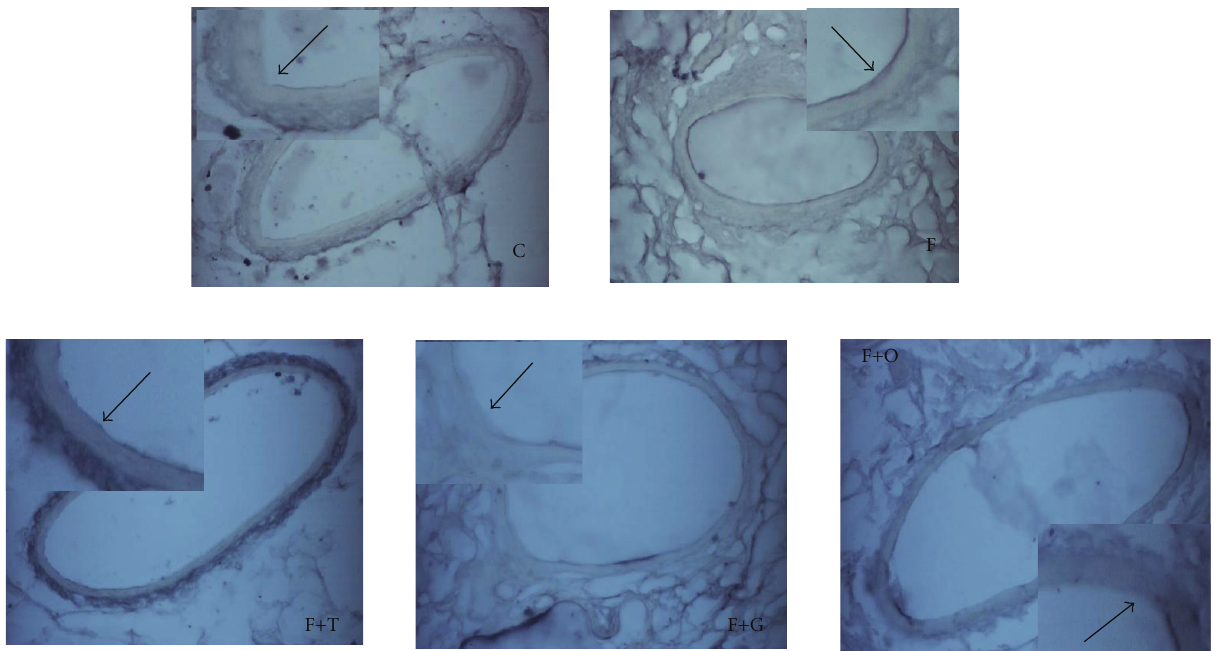
Figure 5: Immunohistochemistry analysis of VCAM-1 in endothelial cells of vascular mesenteric tissue from C, F, F+T, F+G, and F+O groups ( n = 4). Each photo shows an enlarged image. The arrows indicate the VCAM-1 expression in the endothelium: magnification ×